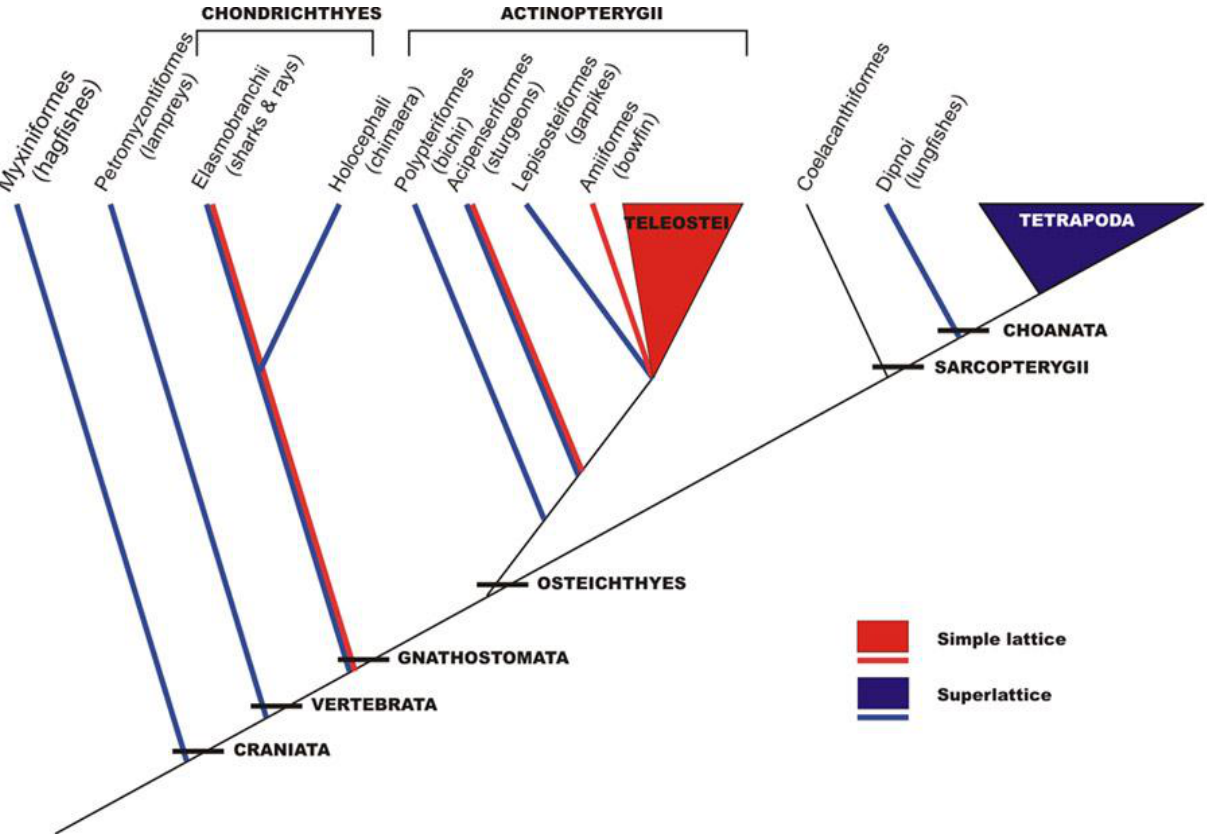
Figure 6. Phylogeny of craniates showing the interrelationships of the major groups and the distribution of the two lattice types. The species studied is enclosed within brackets. Several species were studied in the teleostei (roach, plaice, black molly) and tetrapoda (turtle, frog, rat, rabbit, chicken, human) classes. (Adapted from [26], with permission from